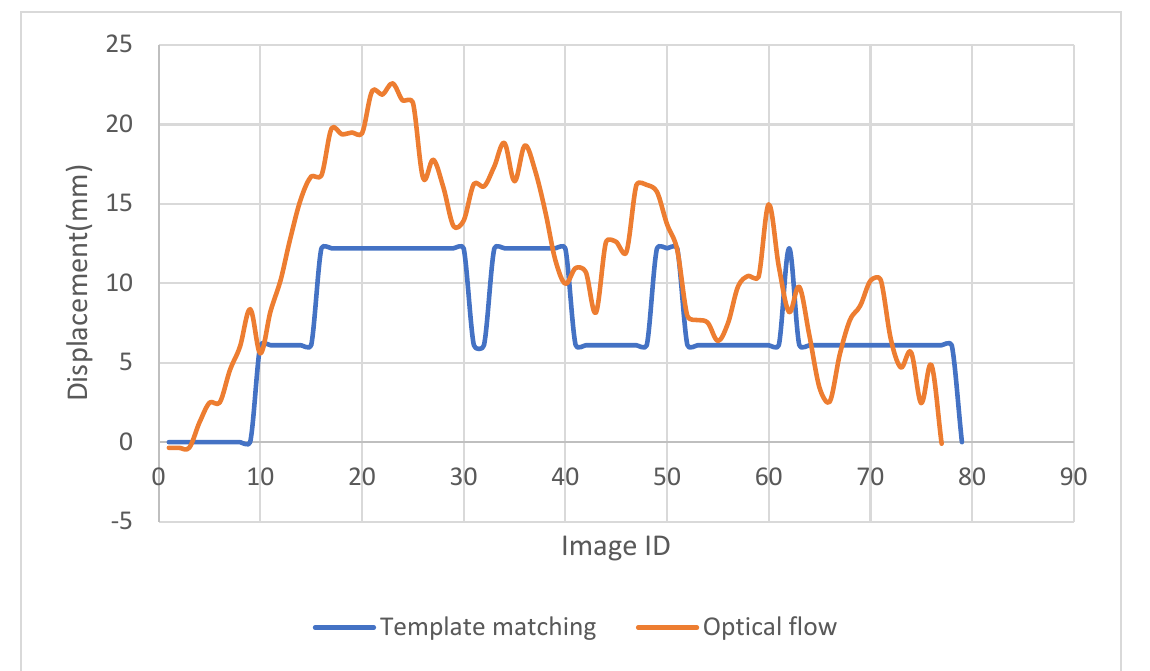
Figure 11. X-displacement of the solar frame detected using the modi fi ed LK optical fl ow method and template matching.